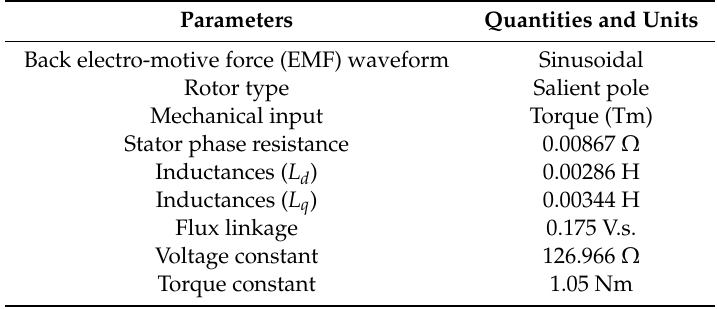
Table 2. Parameters of permanent magnet synchronous generator (PMSG).